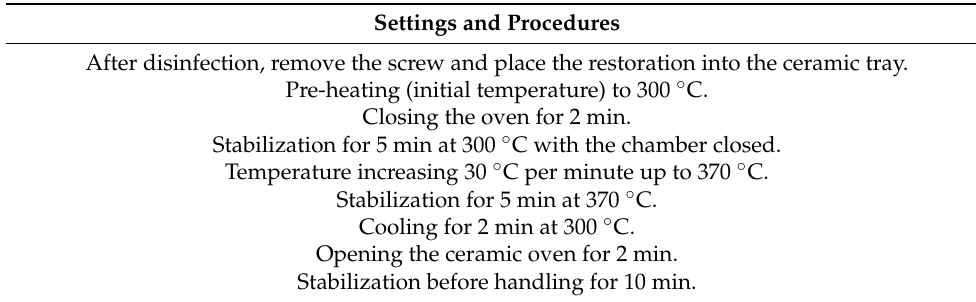
Table 4. Debonding procedures: ceramic oven settings.